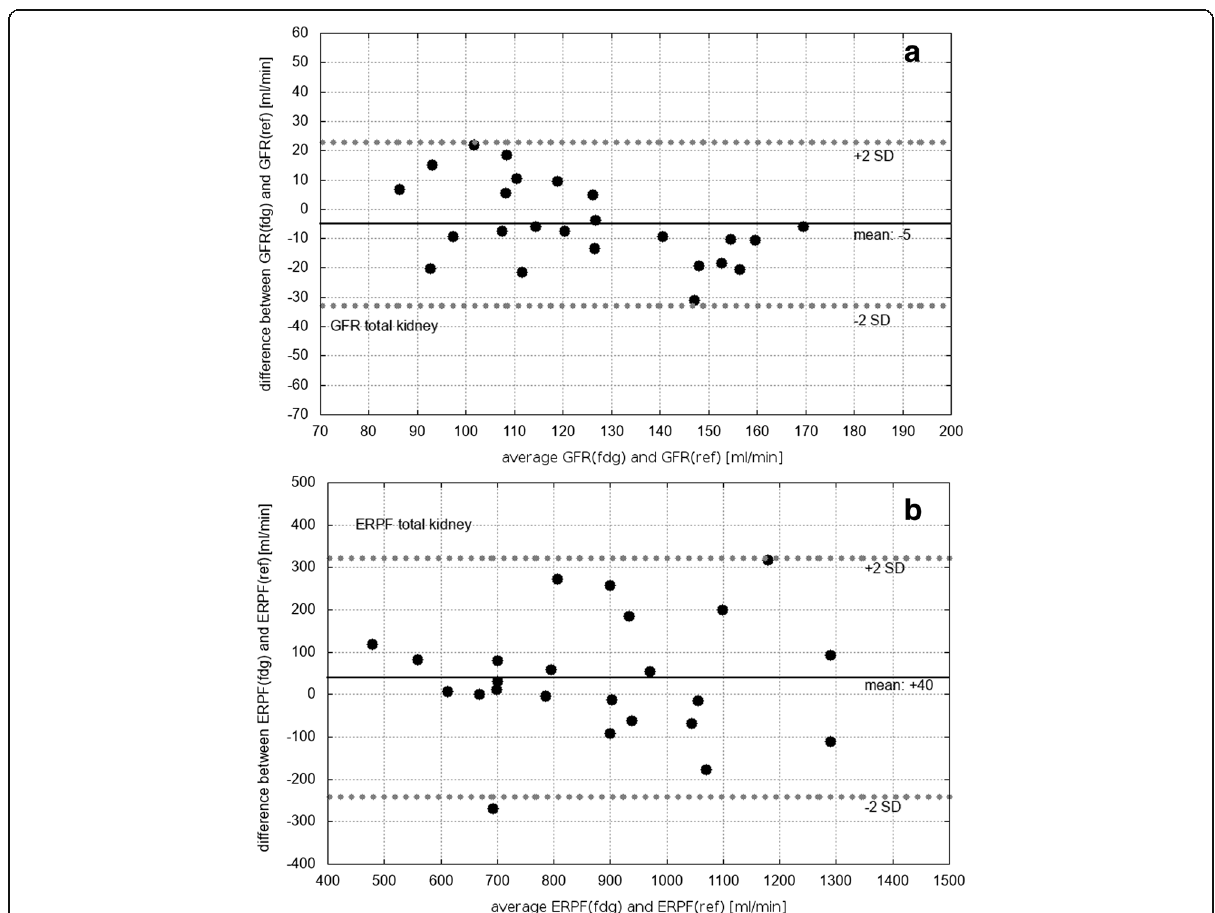
Fig. 6 Bland-Altman-plots of a glomerular filtration rate (GFR) and b effective renal plasma flow (ERPF), only shown for total kidney results. Black lines represent the mean deviation and dashed lines the mean value ± 2 standard deviations